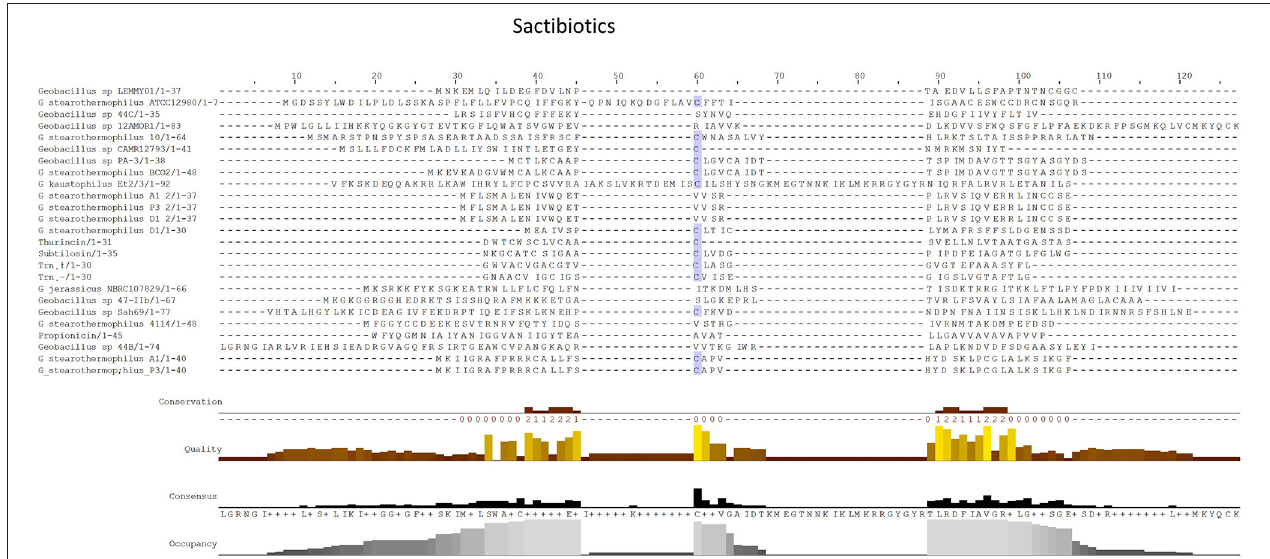
FIGURE 4 | MSA alignment of Sactibiotic peptides predicted by BAGEL3 with characterized sactibiotic peptides.